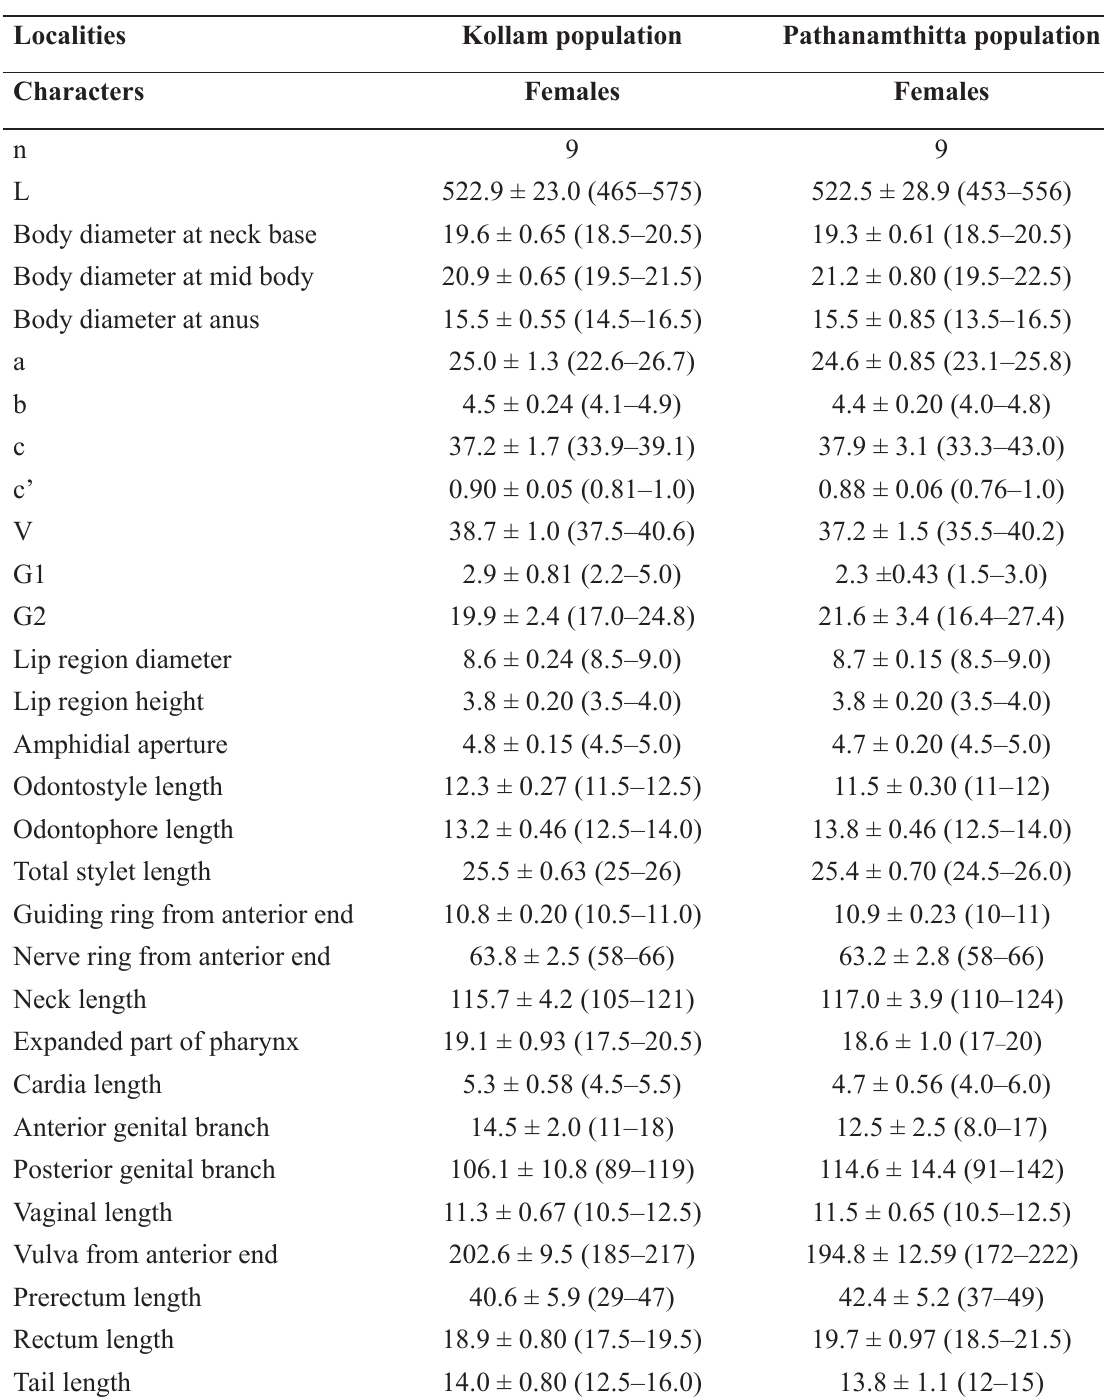
Table 2. Measurements of Basirotyleptus pini Siddiqi & Khan, 1964. All measurements are in μm and in the form: mean ± s.d.